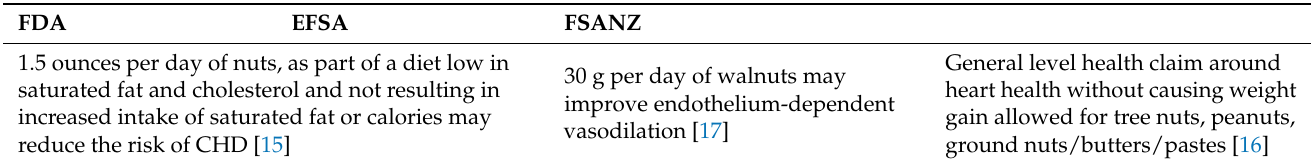
Table 2. Examples of Regulated Health Claims for Nuts and CVD Risk Reduction.